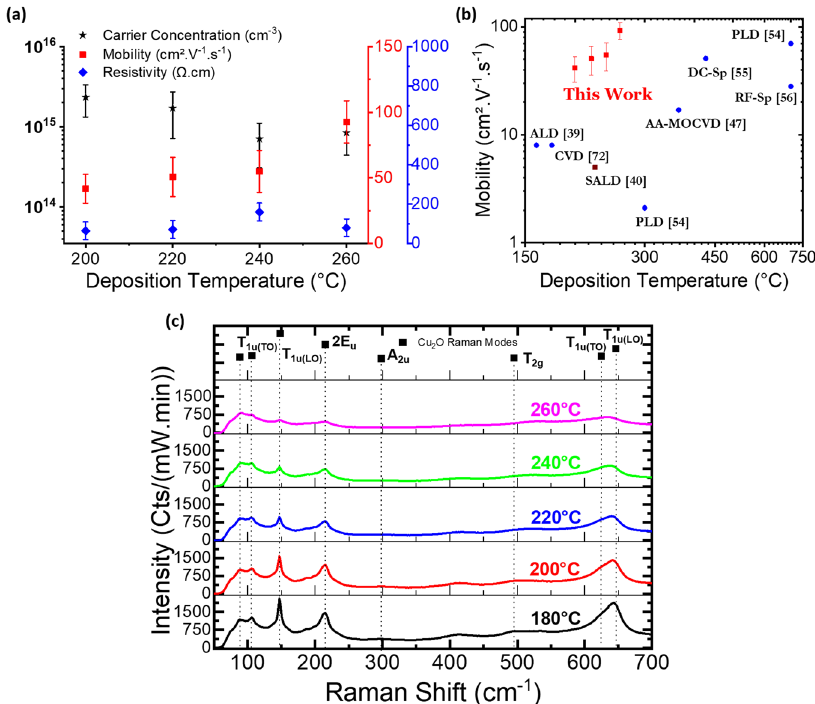
Fig. 4 Transport properties and Raman characterization. a Mobility, resistivity, and carrier concentration of Cu 2 O thin fi lms deposited at different deposition temperatures. b Mobility values for Cu 2 O thin fi lms obtained by different growth techniques as a function of deposition temperature (ALD 39 , CVD 72 , SALD 40 , PLD 54 , AAMOCVD 47 , DC-Sputtering 55 , RF-Sputtering 56 ). c Raman spectra of Cu 2 O thin fi lms deposited on glass substrates at different deposition temperatures. Error bars represent the min/max values obtained for each